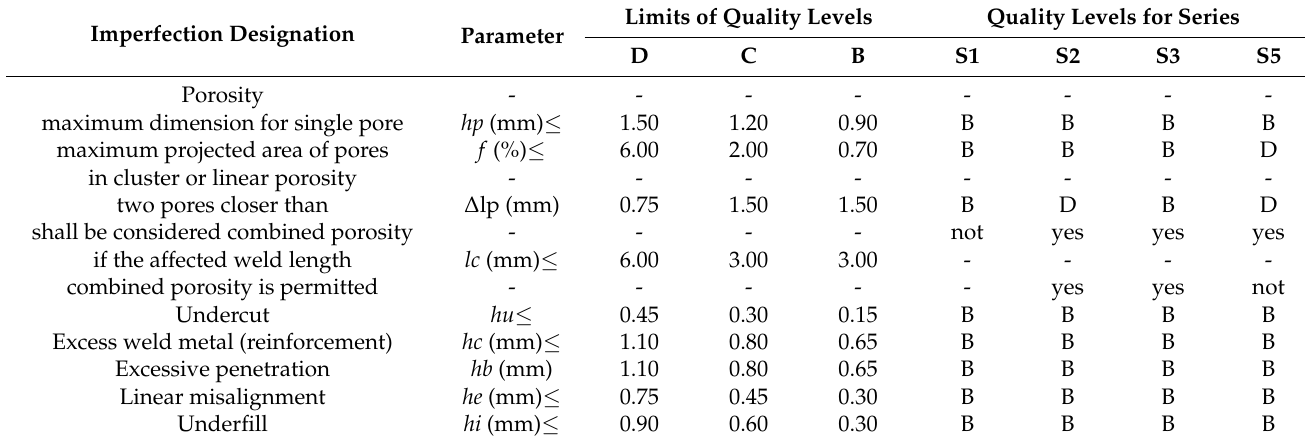
Table 8. Evaluation of the weld quality of the welded